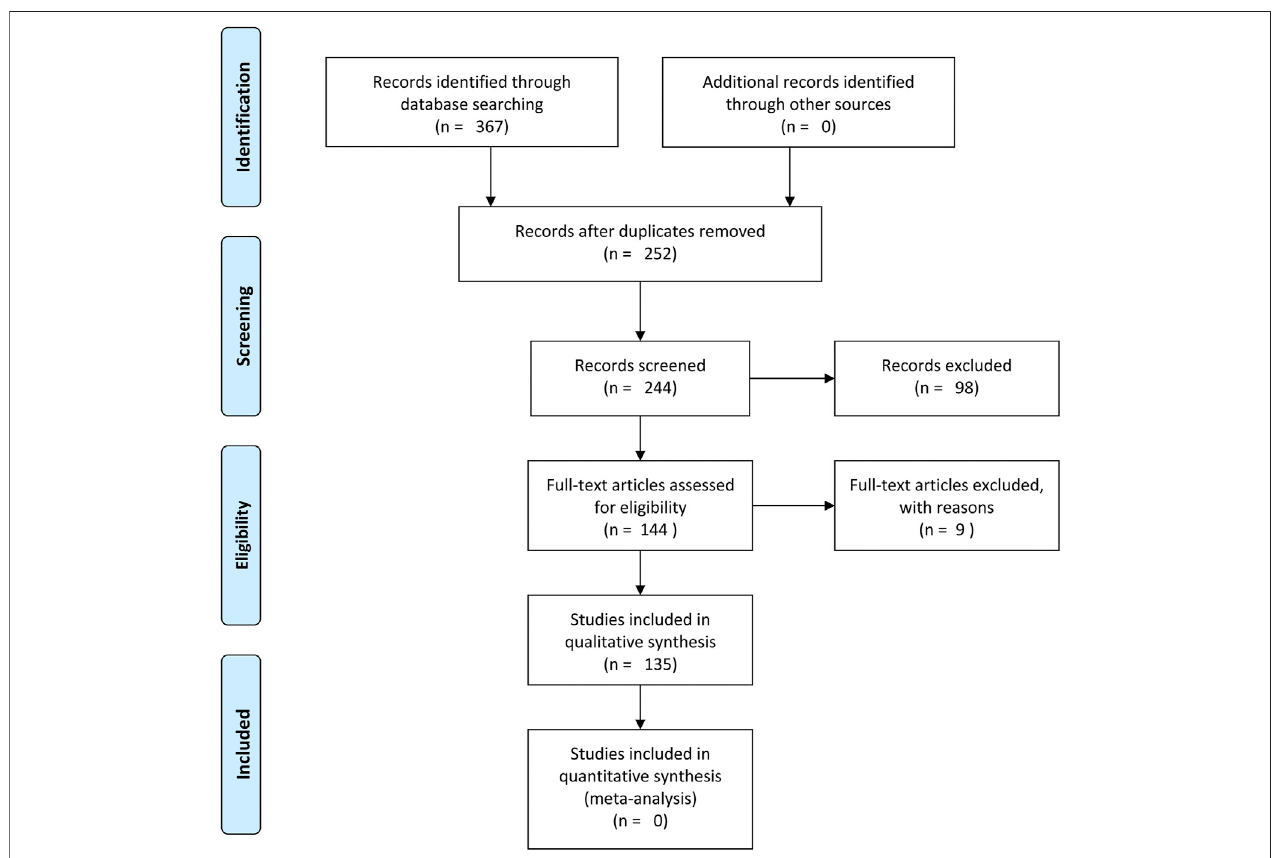
FIGURE 1 | PRISMA fl ow